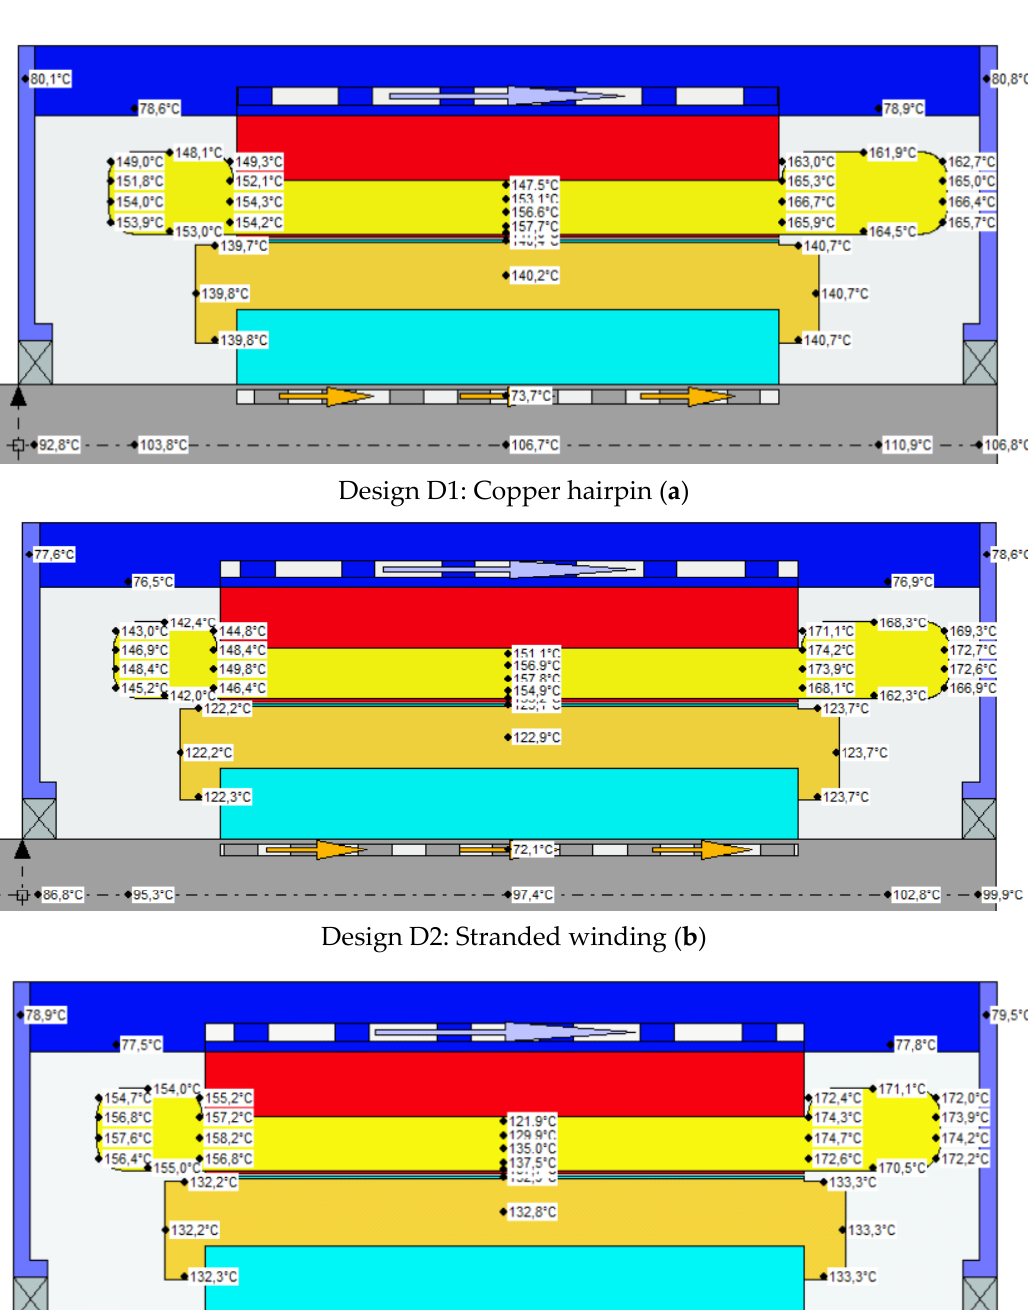
Figure 4 shows the temperatures for the three compared models starting from an ambient